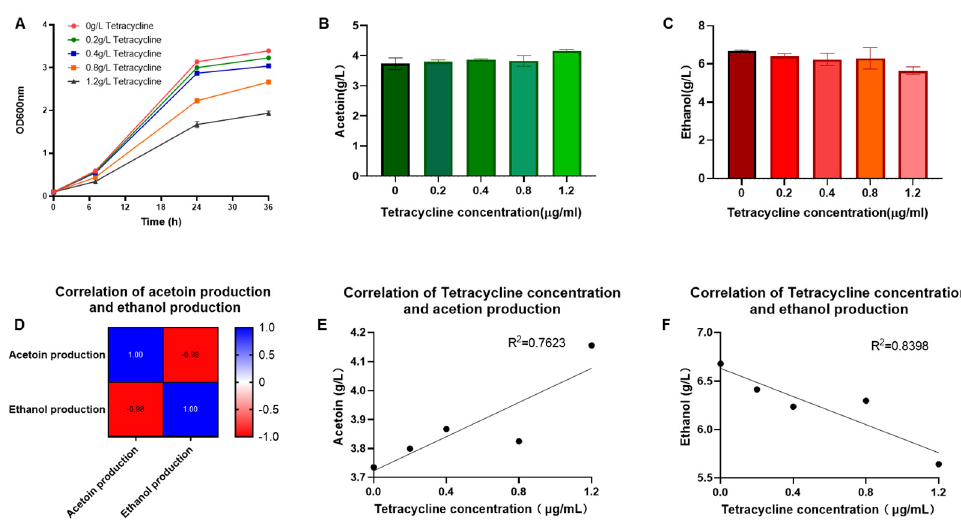
Figure 7. Growth curve ( A ), acetoin ( B ) and ethanol ( C ) production of the recombinant strain ZM4 − 1759dCas12a (pEZ-AldC-Als-NoxE), as well as the correlation of acetoin production with ethanol production ( D ), the correlation of tetracycline with acetoin ( E ) and ethanol ( F ) production . dCas12a − based CRISPRi system of Z. mobilis was applied to redirect the carbon flux from ethanol production to acetoin biosynthesis, which includes dCas12a controlled by the inducible promoter P tetR that was stably integrated into the ZMO1759 locus, and the editing plasmid containing a constitutively expressed sgRNA targeting pdc . Cells were cultured in flasks with the shaking speed of 200 rpm supplemented with different concentrations of the inducer tetracycline. Values are the means of experiments with three or more technical replicates, error bars are standard deviation.